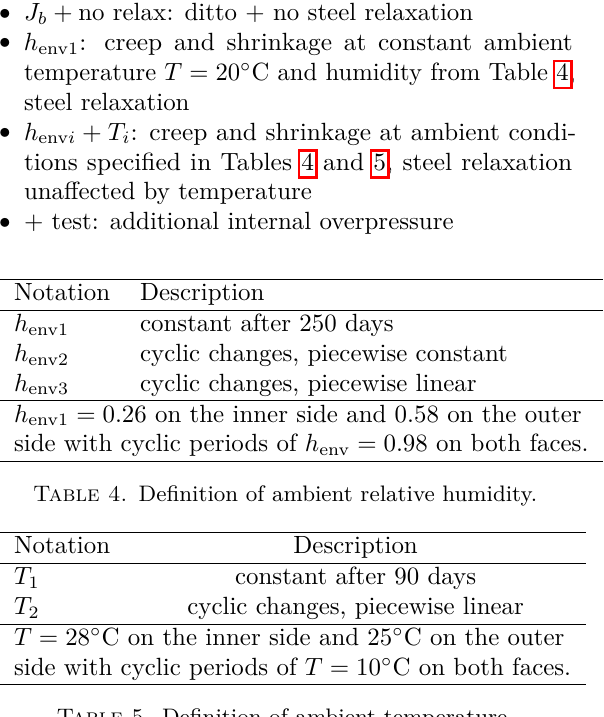
Table 5. Definition of ambient